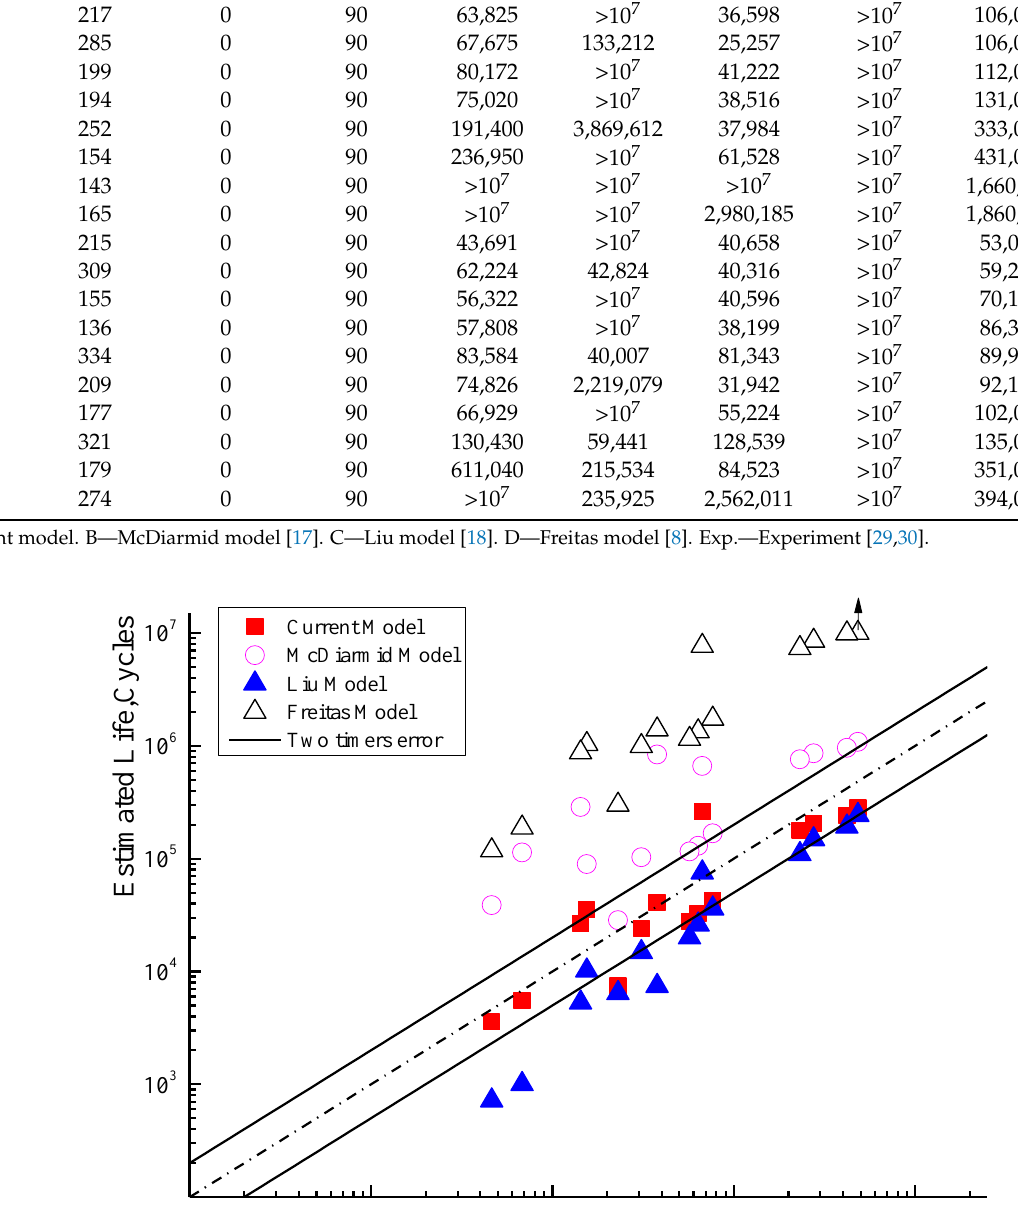
Figure 8. Experimental and predicted results for carbon structural steel SM45C. 4. Conclusions A new model for the life prediction of multiaxial high-cycle fatigue, which is based on the twin-shear unified yield criterion, has been proposed. The model was applied to predict the fatigue life of two different materials subjected to a broad range of proportional and non-proportional iso-frequency load paths, and the yielded simulated results were in good agreement with experimental data, most of which possess an error of less than two times the experimental data. The competitiveness of the proposed model, compared with